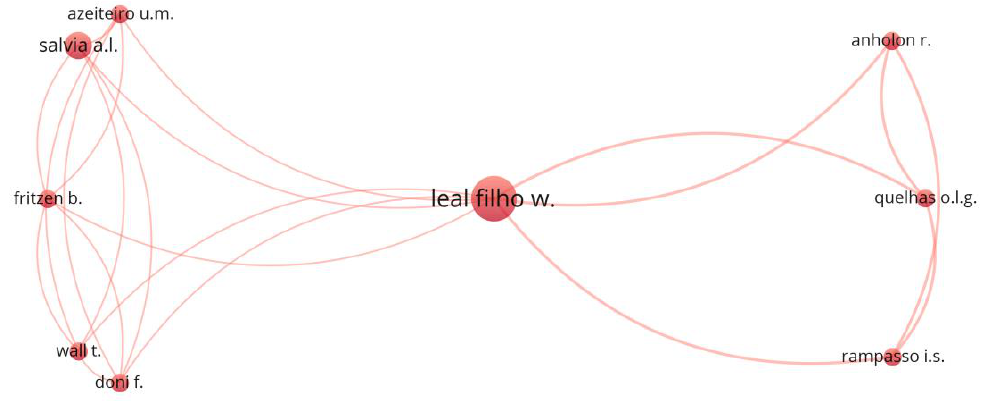
Figure 4. Authors’ cooperation network based on co-authorship.